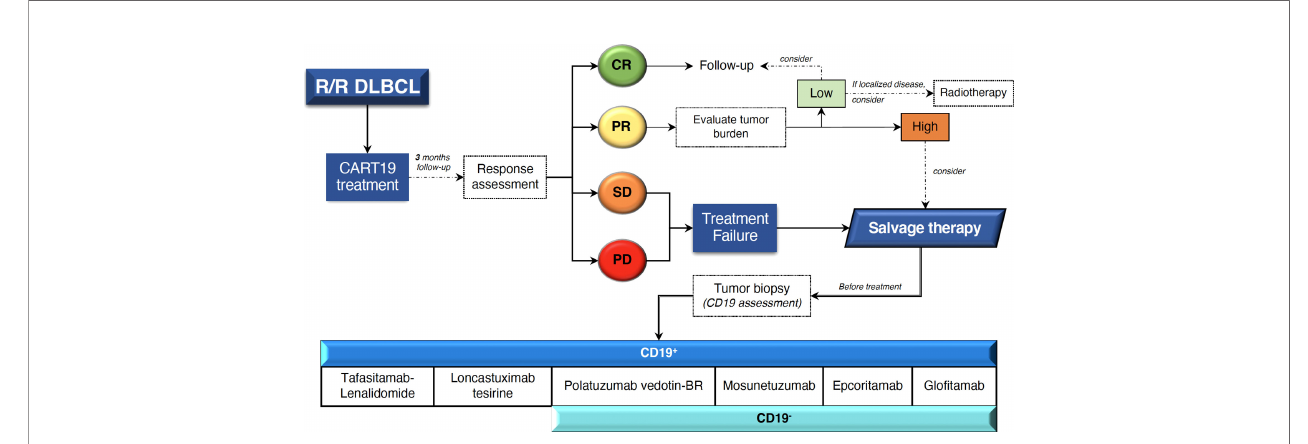
FIGURE 3 | Management proposal for patients with R/R DLBCL who fail CART19 treatment. Novel clinically relevant therapies based on CD19 tumor expression are shown. CR, complete response; PR, partial response; SD, stable disease; PD, progressive disease;